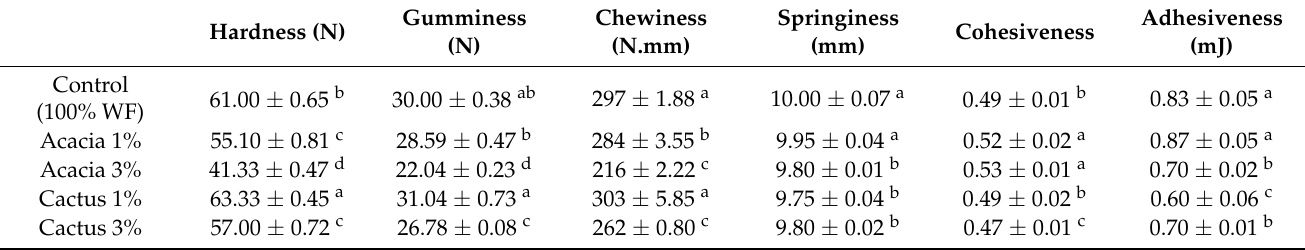
Table 3. Effect of acacia and cactus gums on the TPA properties of flour